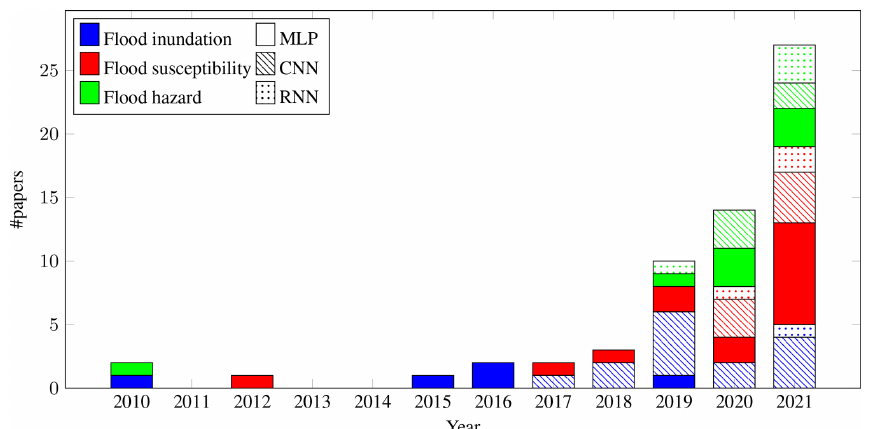
Figure 4. Publications by year, type of application, and type of DL model. The increasing trend of the last 5 years has been mostly driven by the applications in flood susceptibility and flood hazard.